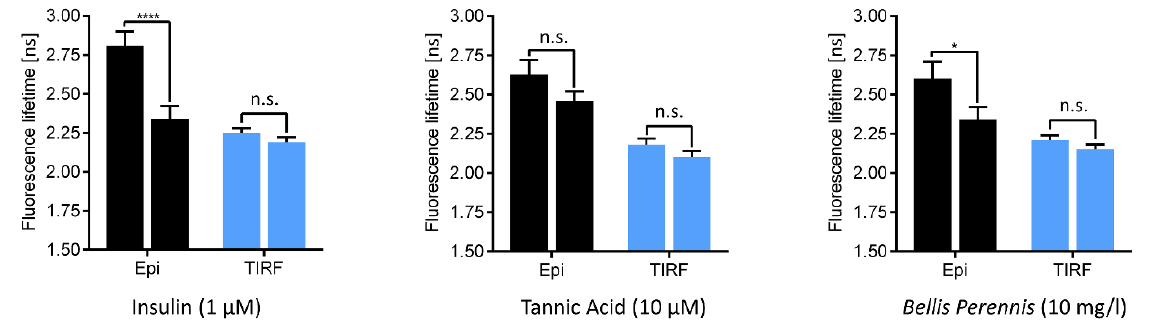
Figure 5. Fluorescence lifetime of CHO-K1 hIR/GLUT4-myc-GFP cells prior to (left columns) and subsequent to (right columns) 30 min stimulation with insulin, tannic acid or Bellis perennis extract. Results show means ± standard deviations of 13 (insulin) or 14 (tannic acid, Bellis perennis ) cell specimens upon whole cell (“EPI”) or TIRF illumination. Levels of significance: * p < 0.01, **** p < 0.0001, and n.s. no significant difference for comparison of epi- and TIR illumination (reproduced from [15], Supplementary Information, with modifications).